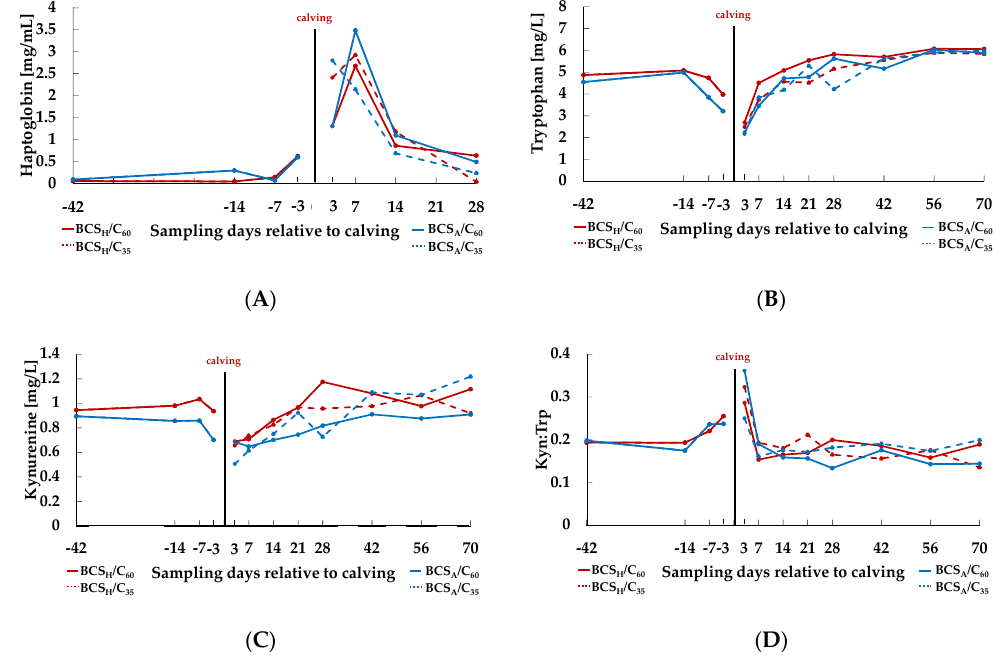
Figure 5. Blood concentrations of haptoglobin (Hpt, A ), Tryptophan (Trp, B ), Kynurenine (Kyn, C )